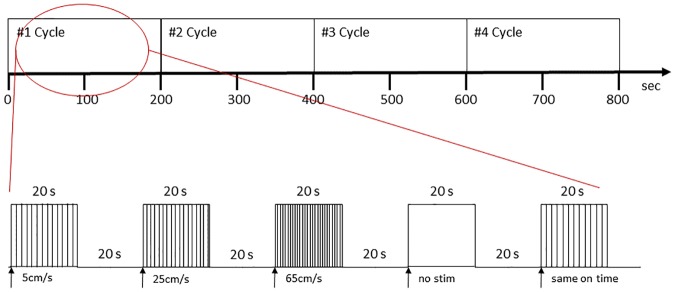
Experiment stimulus design.Random-balanced experimental block design in one functional scan session. One session includes 4 cycles of the 5 stimulus conditions and the total measurement time of one session was 13:20 min.